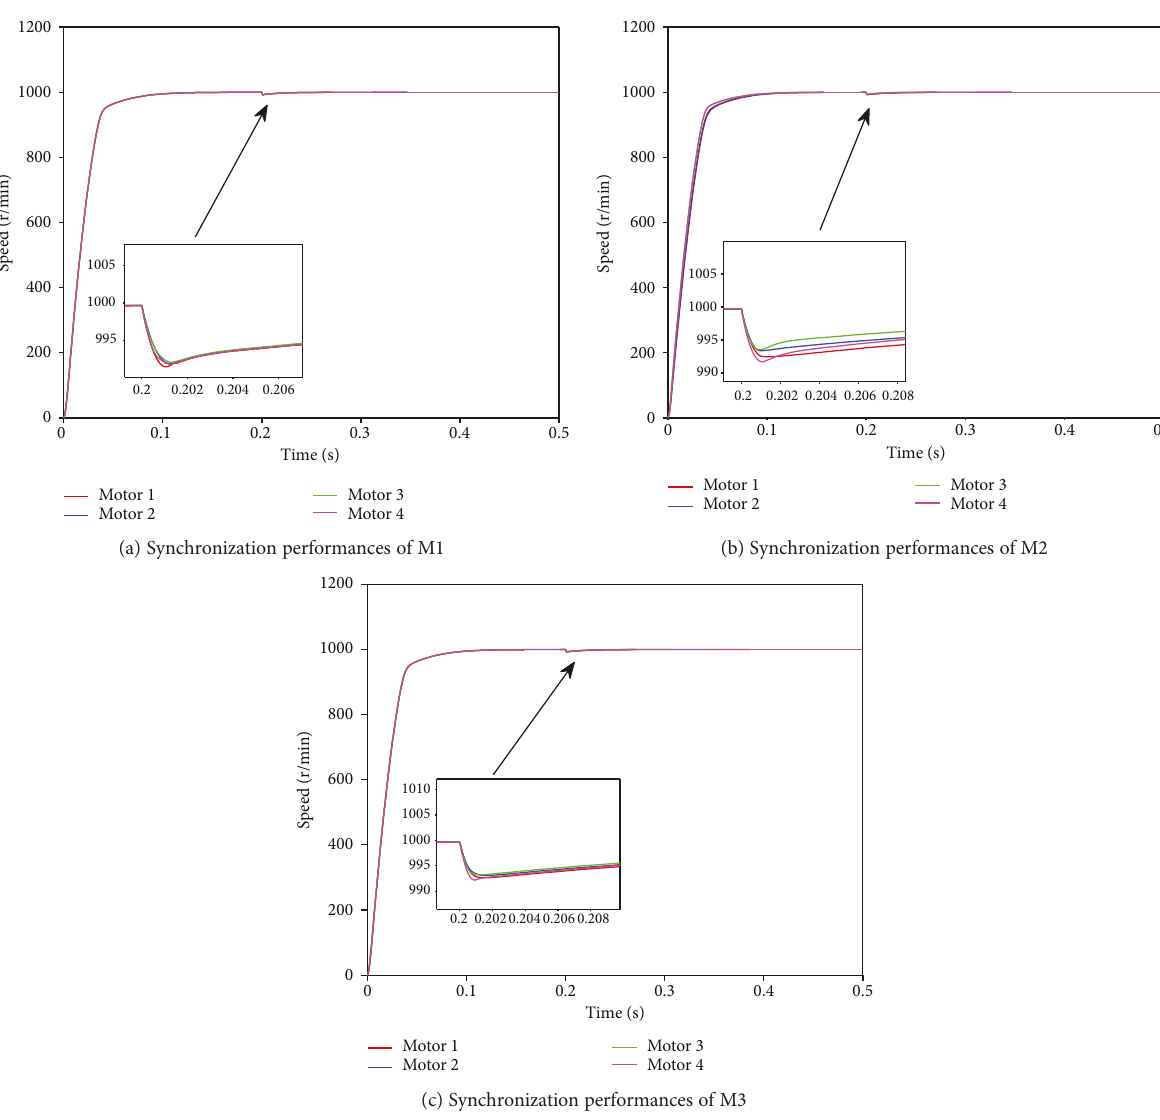
Figure 6: Speed synchronization performance